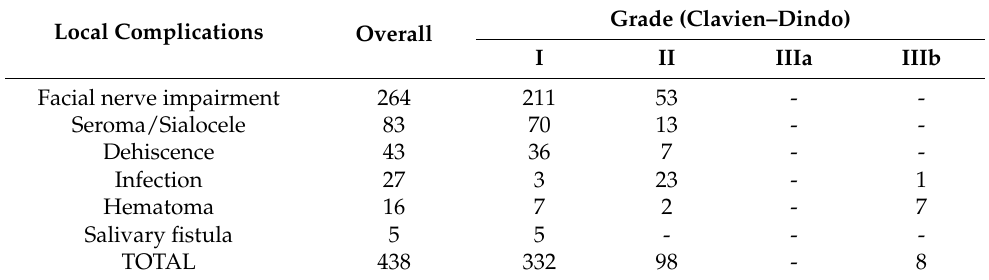
Table 4. Local perioperative complications after parotidectomy according to Clavien–Dindo